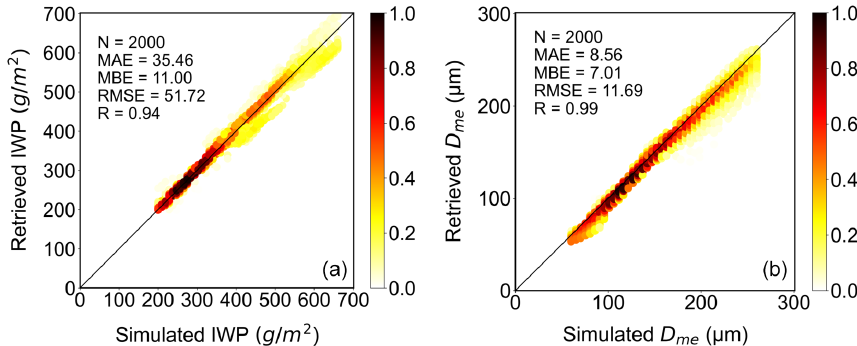
Figure 10. The scatterplots of the randomly generated 2000 test data and the retrieved results. Panels (a) and (b) are for the IWP and D me ,